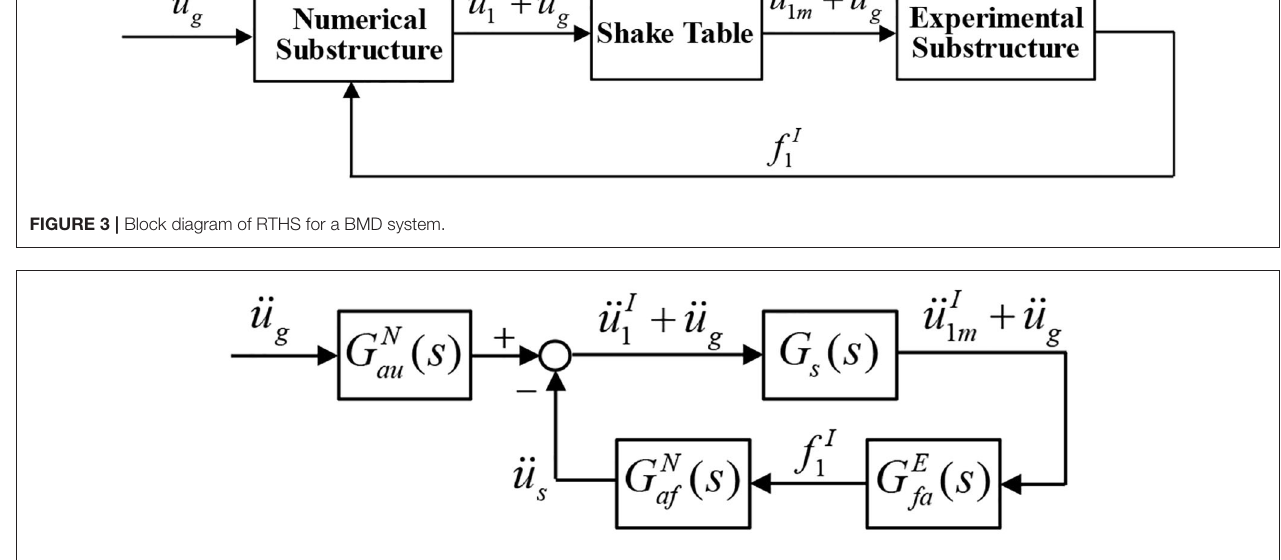
FIGURE 4 | Closed loop transfer function of RTHS for a BMD